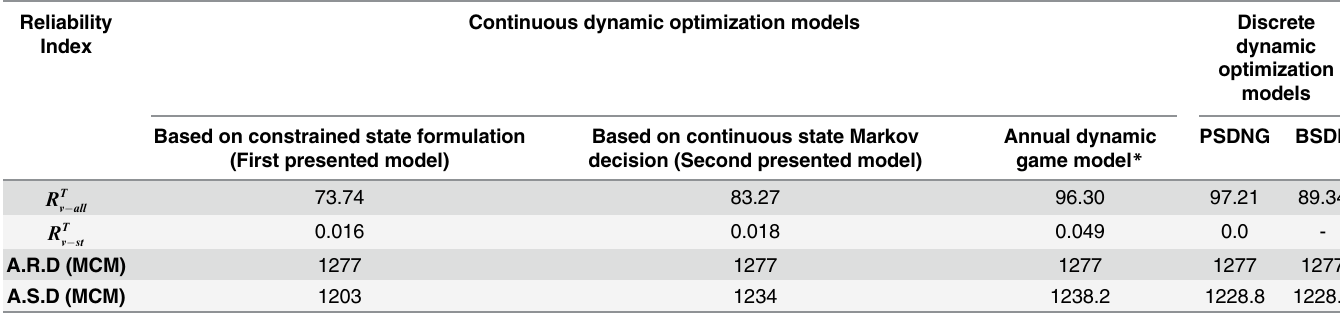
Table 7. The comparison of system reliability indices among presented models, annual form of dynamic game, PSDNG and BSDP